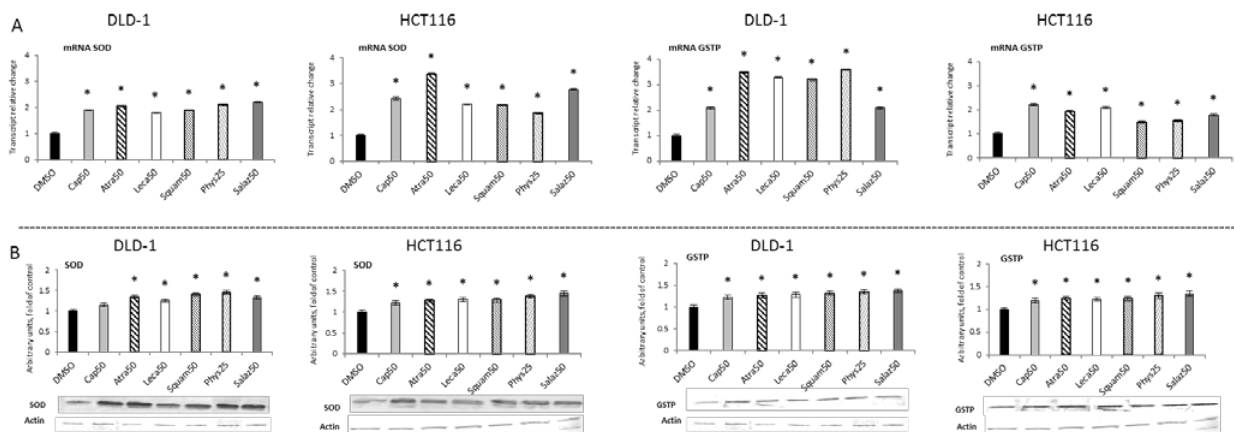
Figure 4. The effect of lichen-derived compounds on the expression of selected Nrf2 target genes: SOD and GSTP in DLD-1 and HCT116 cells. ( A ) Levels of SOD and GSTP transcripts. The values (fold of control) are presented as the means ± SEM from three separate experiments. ( B ) Level of SOD and GSTP proteins. Representative Western immunoblots are presented under the graphs. Results (means ± SEM from three separate experiments) are presented as a fold change to control after normalization against the level of actin. Asterisks (*) denote statistically significant changes from the control group ( p ≤ 0.05). DMSO , vehicle control; Cap50 , caperatic acid (50 µM); Atra50 , atranorin (50 µM); Leca50 , lecanoric acid (50 µ M); Squam50 , squamatic acid (50 µ M); Phys25 , physodic acid (25 µ M); Salaz50 , salazinic acid (50 µ M).